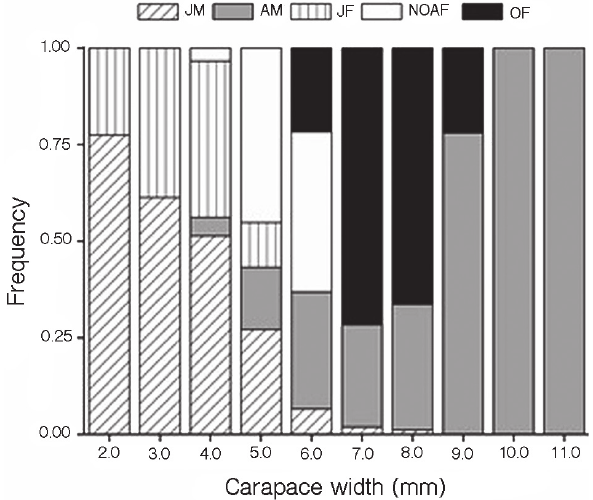
Figure 2. Frequency of Panopeus austrobesus by size class in the mussel farm at Itaguá Beach, Ubatuba, State of São Paulo, Brazil (JM, juvenile male; AM, adult male; JF, juvenile female; NOAF, non-ovigerous adult female; OF, ovigerous females).